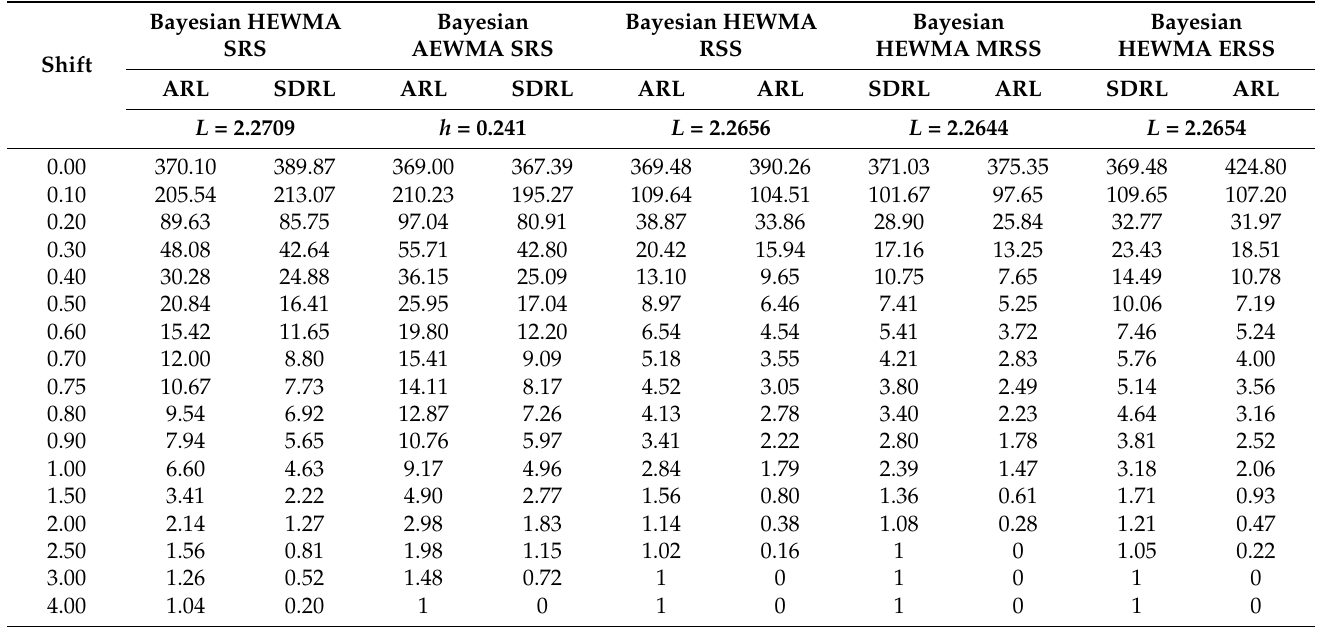
Table 2. The ARL and SDRL values of Bayesian HEWMA and Bayesian AEWMA control chart for